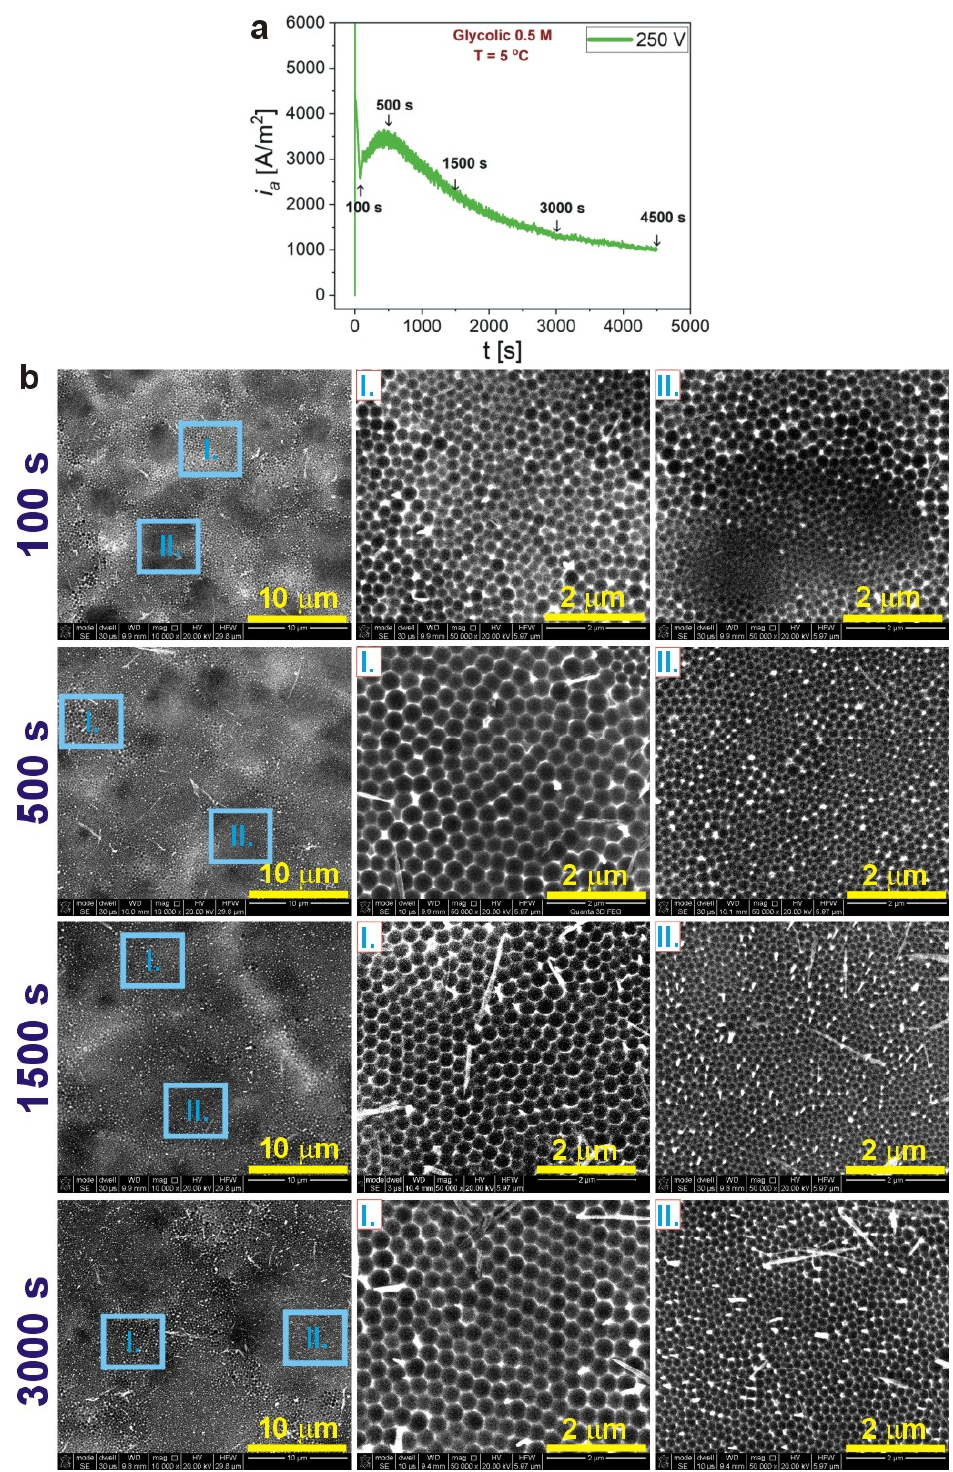
Figure 3. Current density ( i a ) versus time ( t ) transients for the samples anodized in 0.5 M glycolic acid solution, at 250 V and T = 5 °C (the arrows indicate the time after which the anodization was stopped and the sample was analyzed by SEM) ( a ); corresponding SEM images of the Al substrates after the dissolution of AAO obtained during anodization in 0.5 M glycolic acid solution at 250 V, 5 °C for different anodizing time ( b ).